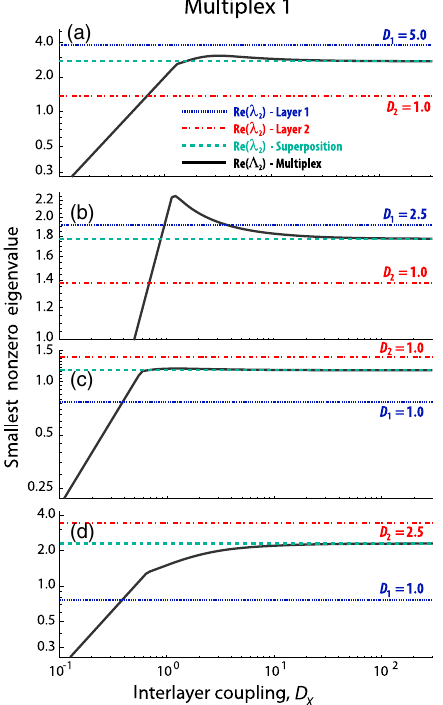
FIG. 6. Characteristic rate of convergence to stationary state solution of a continuous-time Markov chain in multiplex 2 for different pairs ð D 1 ; D 2 Þ . The value of the smallest (in terms of its real part) nonzero eigenvalue ð Λ 2 Þ of the supra-Laplacian is displayed as a function of interlayer coupling D X